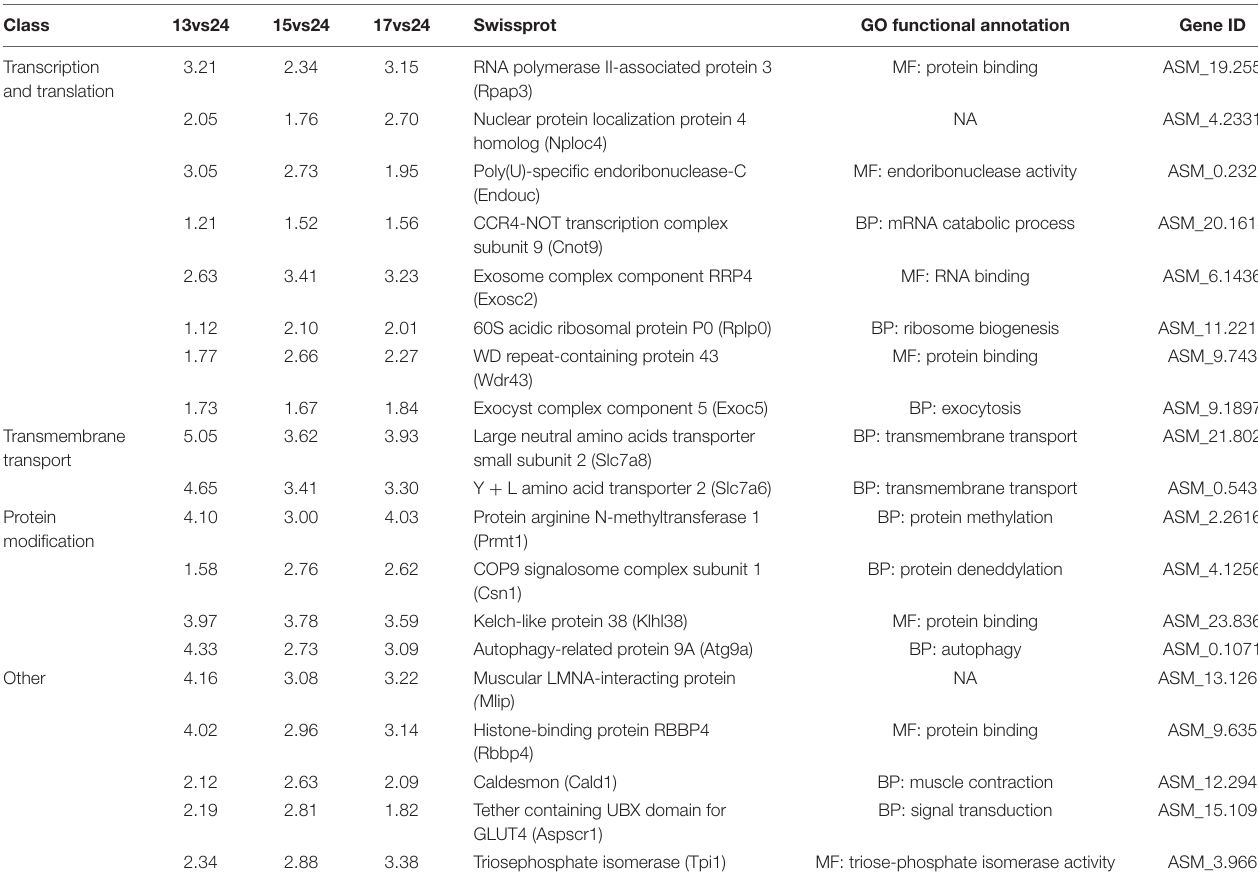
TABLE 1 | Functional annotation and classification of 19 up-regulated key candidate genes in transcriptional and alternative splicing regulation. Class 13vs24 15vs24 17vs24 Swissprot GO functional annotation Gene ID Transcription and